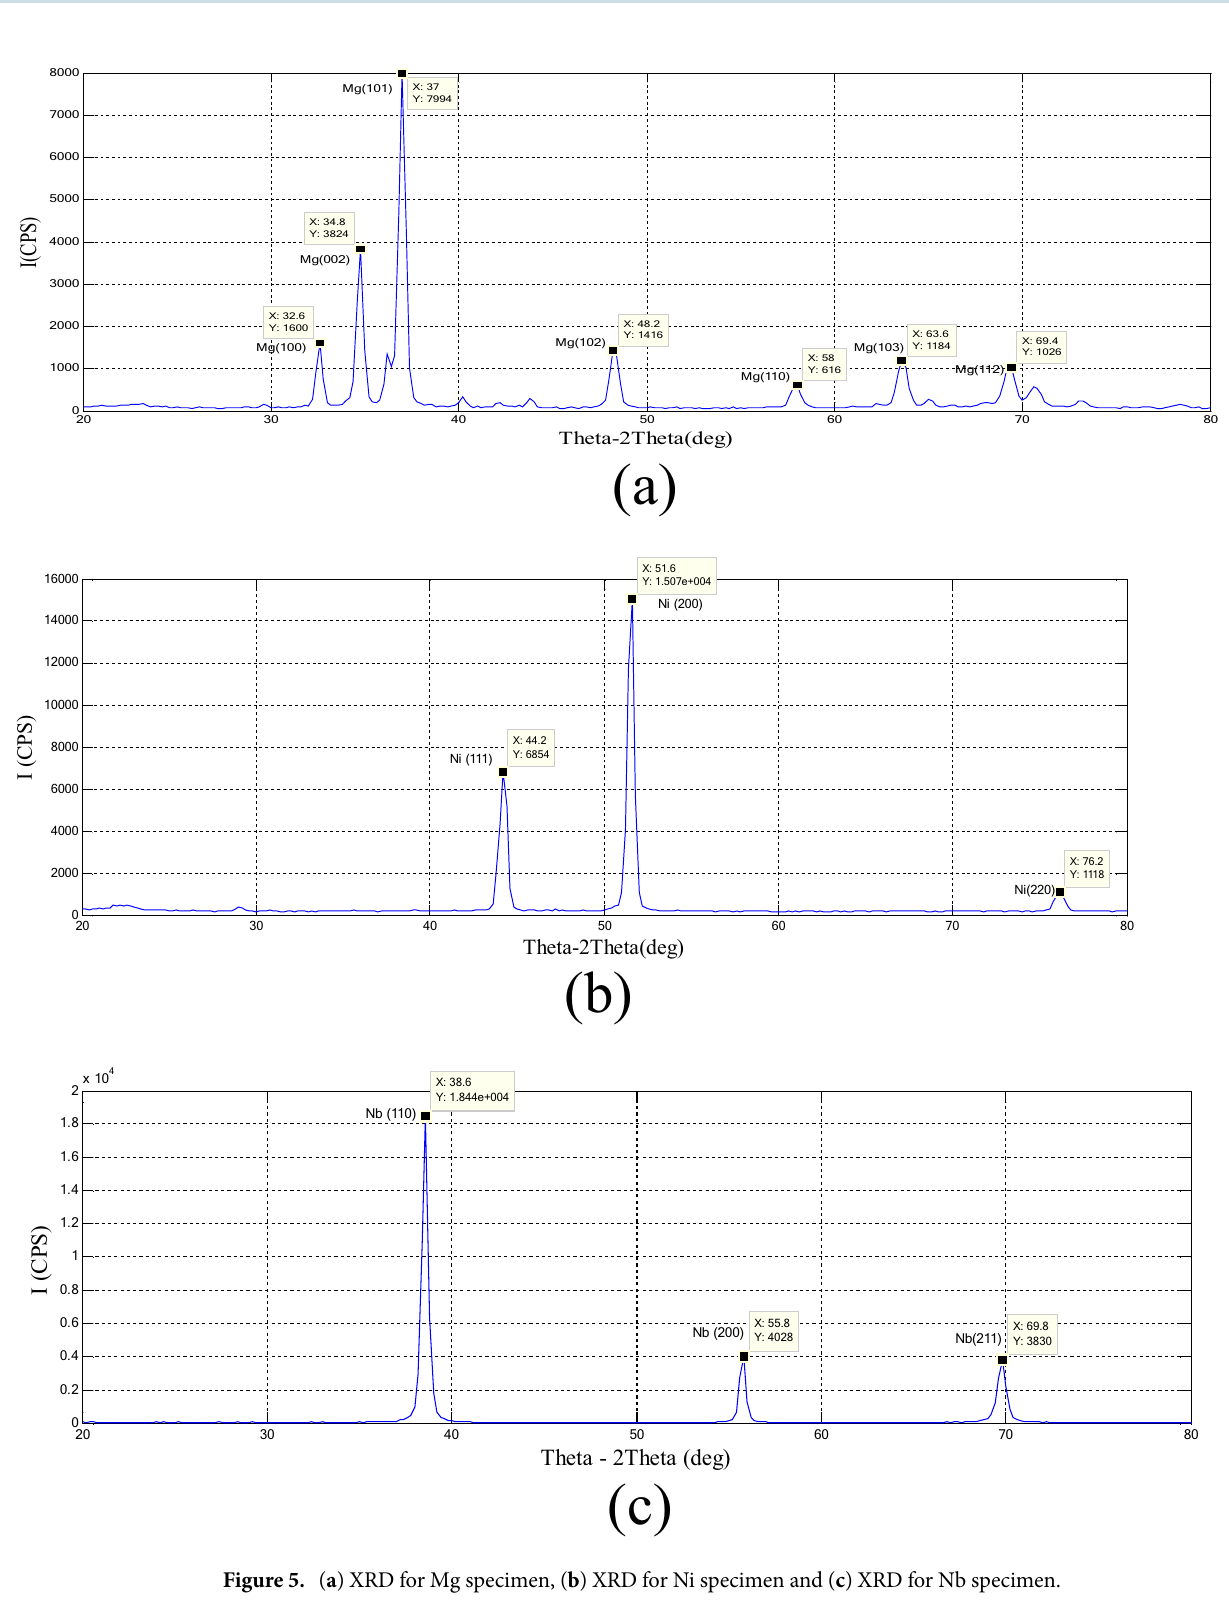
Figure 5. ( a ) XRD for Mg specimen, ( b ) XRD for Ni specimen and ( c ) XRD for Nb